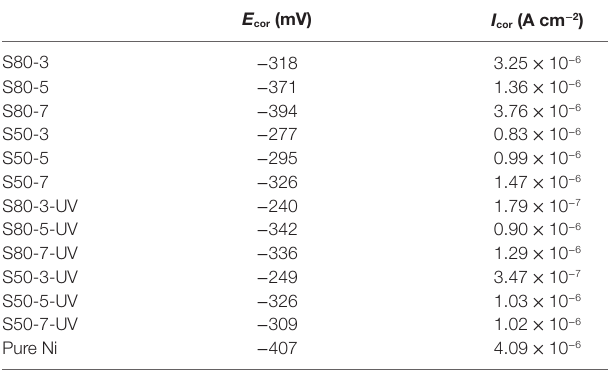
role in the whole strengthening of the nanocomposite coatings.